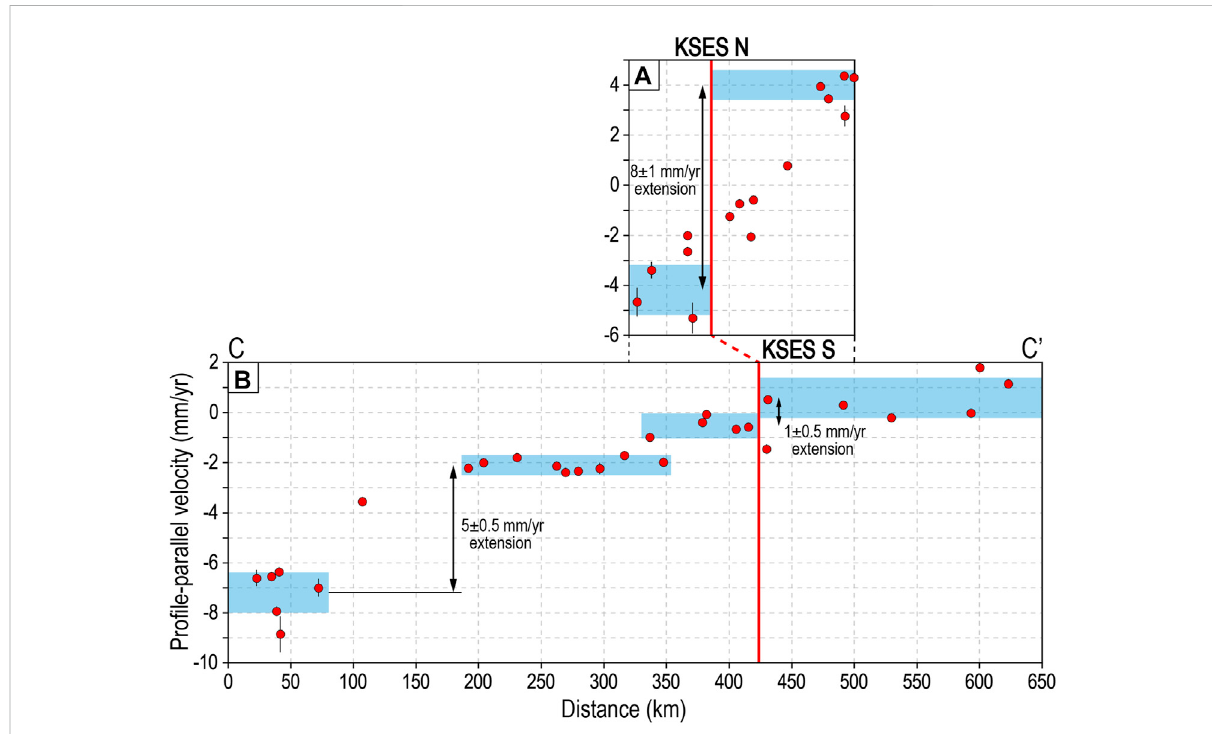
FIGURE 6 GPS velocities parallel to the pro fi le C – C ’ (see location in Figure 3). (A,B) show velocities in swaths 3 and 4, respectively. Colored stripes show velocity ranges. The red bold line denotes the fault location of the Kongur Shan Extensional